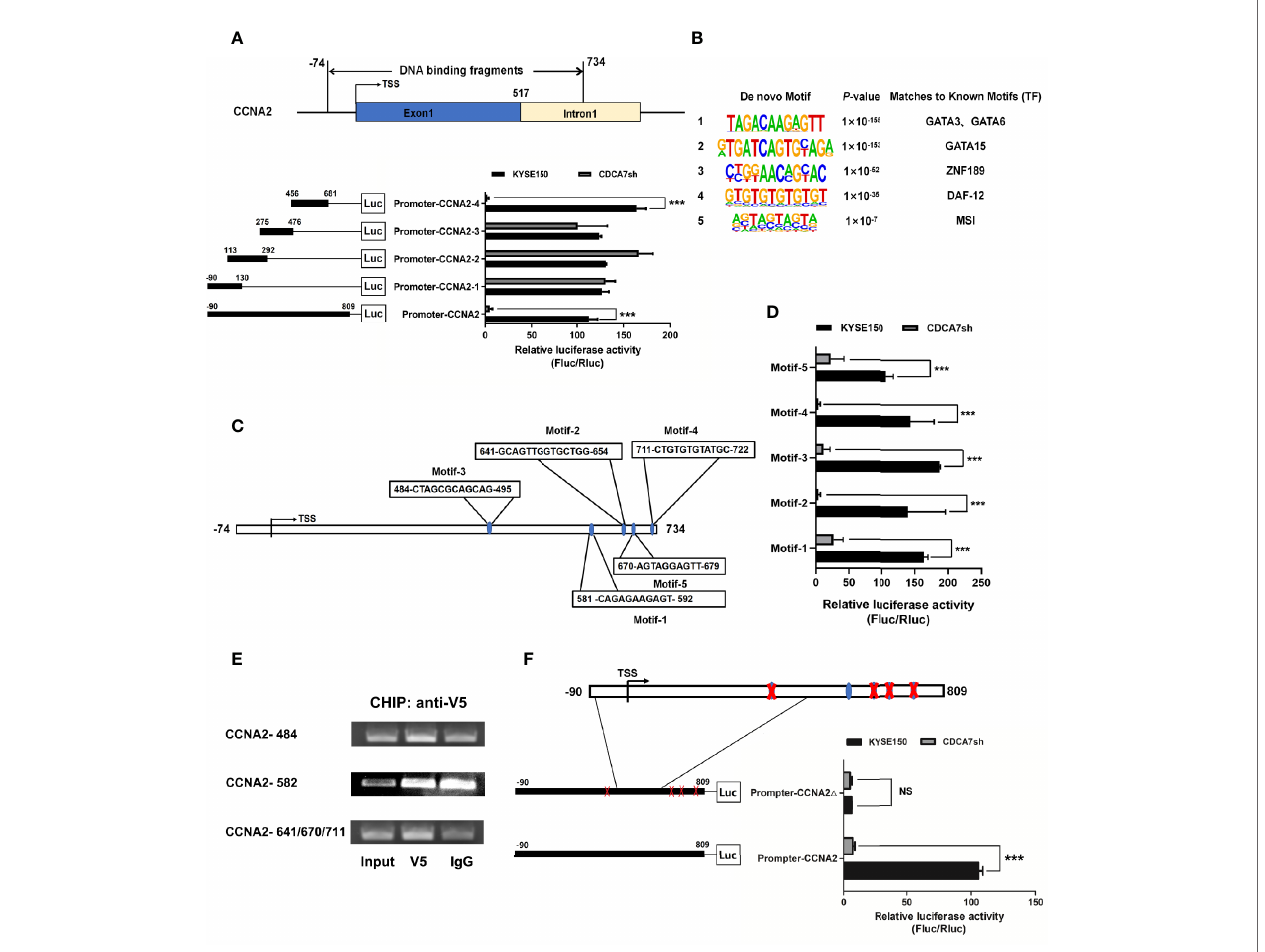
FIGURE 5 | CDCA7 directly binds to CCNA2 and increases its transcription activity in ESCC cells. (A) CDCA7 binds with CCNA2 from − 74 to 734 bp in the ChIP-seq and luciferase reporter assays showed that 456 to 809 bp of CCNA2 were the core regions regulated by CDCA7 . (B) Five predicted motifs were analyzed from the DNA-binding fragments obtained from the ChIP-seq. (C) Five DNA fragments in the 456 – 809-bp region were highly similar to motif-1, motif-2, motif-3, motif-4, and motif-5. (D) Luciferase reporter assays showed that CDCA7 may regulate the transcription of the target genes through the fi ve motifs. (E) ChIP-PCR showed that CDCA7 binds to the CCNA2 at the position of 484 – 495, 641 – 654, 670 – 679, and 711 – 722 bp in ESCC cells. (F) Luciferase reporter assays showed that CDCA7 could not activate the expression of downstream reporter gene when the four binding sites of 484 – 495, 641 – 654, 670 – 679, and 711 – 722 bp were knocked out. (P > 0.05, NS; P ≤